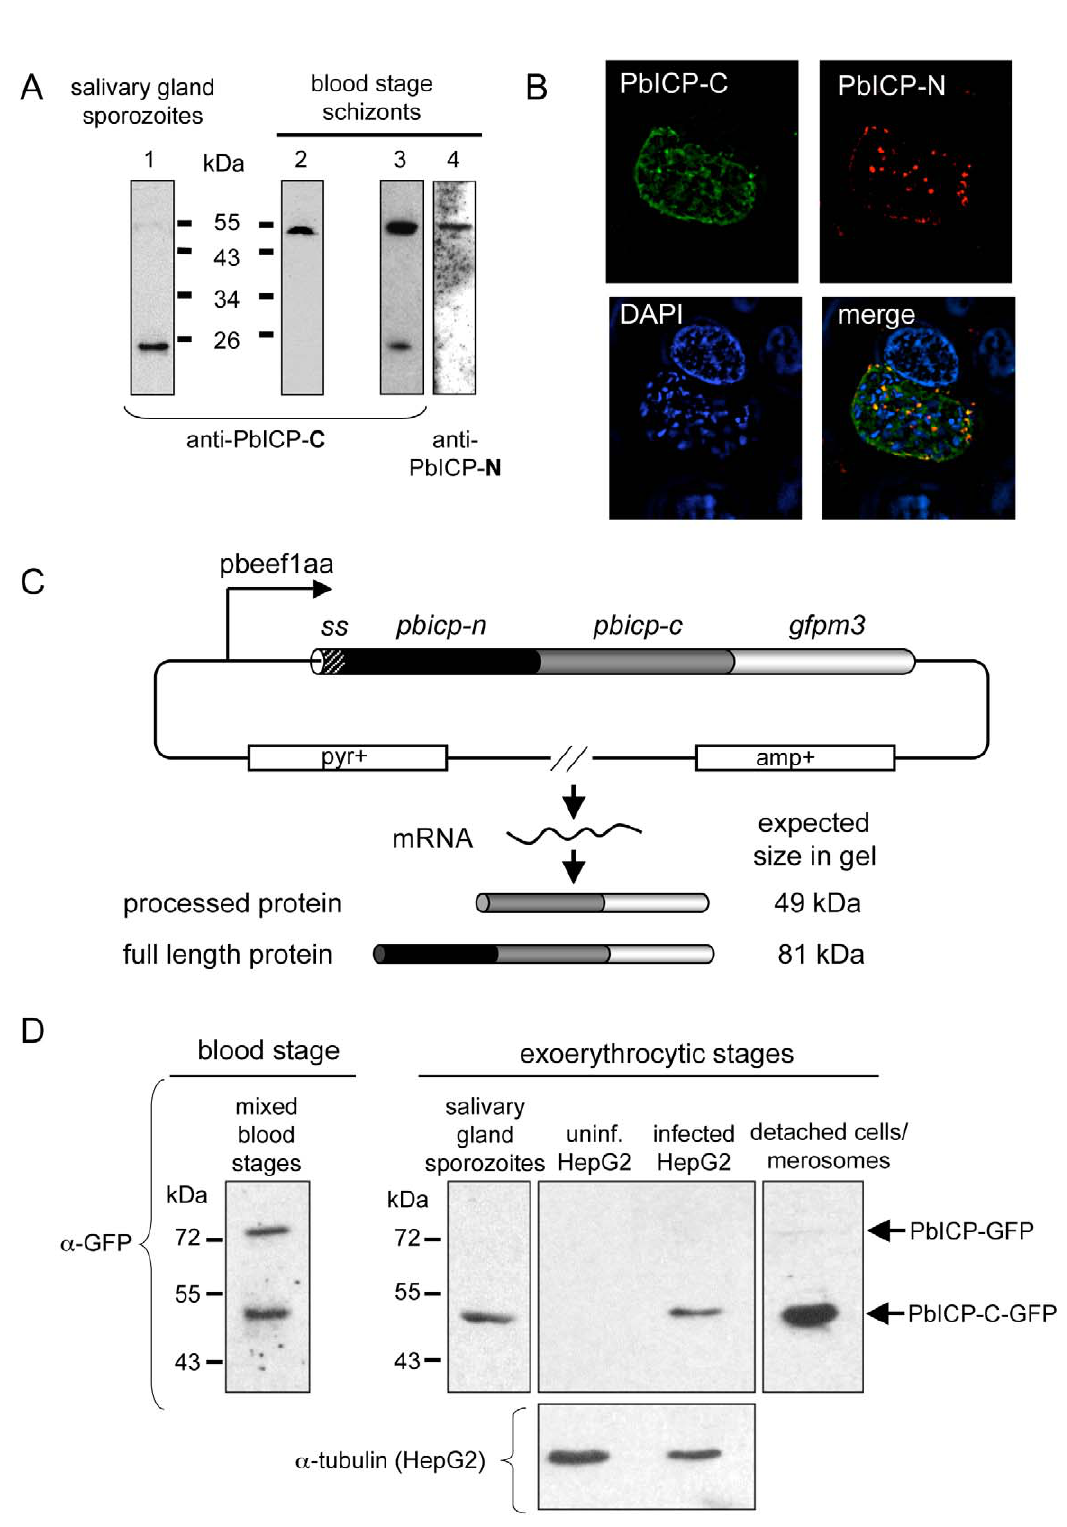
Figure 5. PbICP is posttranslationally processed in the blood stage and exoerythrocytic stages. ( A ) Domain-specific western blot analysis of protein extracts prepared from P. berghei salivary gland sporozoites and blood stage schizonts. Protein extracts of blood stage schizonts (two independent samples: one in lane 2 and a second one in lane 3 + 4) and sporozoites were separated by SDS-PAGE and blotted on nitrocellulose filters. Filters were then probed with antisera against the chagasin-like domain of PbICP (anti-PbICP-C, rabbit, lane 1–3) or the N-terminal domain (anti- PbICP-N, lane 4). Anti-PbICP-C antiserum detected the full-length inhibitor (55 kDa) as well as the processed form after cleavage of the N-terminal extension domain (23 kDa), whereas anti-PbICP-N antiserum detected only the full-length protein of 55 kDa. ( B ) IFA of a P. berghei -infected HepG2